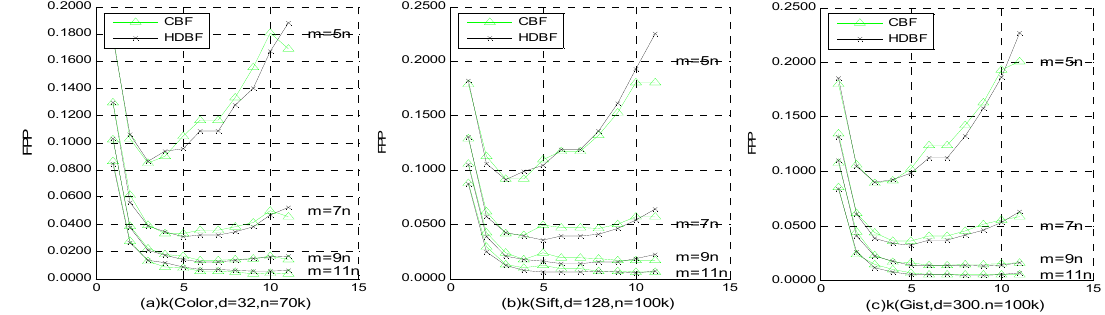
Figure 5. FPPs of the CBF and HDBF for different k and memory cost.